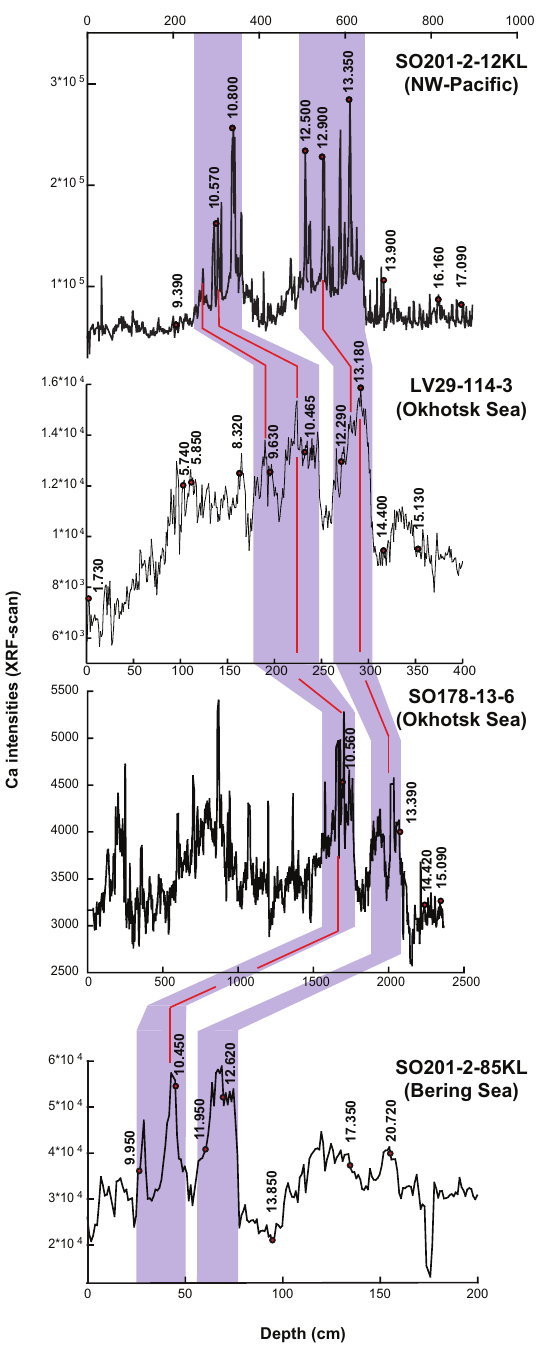
Fig. 2. Stratigraphic framework of sediment records from the west- ern Bering Sea (SO201-2-85KL) and Okhotsk Sea (SO178-13-6). Red lines indicate correlation points to the established stratigraphy of Okhotsk Sea record LV29-114-3 and high-resolution sediment core SO201-2-12KL from the subarctic northwest Pacific (Max et al., 2012). Given are the Ca-intensity records achieved from core logging (XRF) together with raw AMS 14 C datings (red spots with vertical numbers). Purple shaded areas mark prominent carbonate maxima in the sediment records during the Bølling/Allerød and early Holocene.